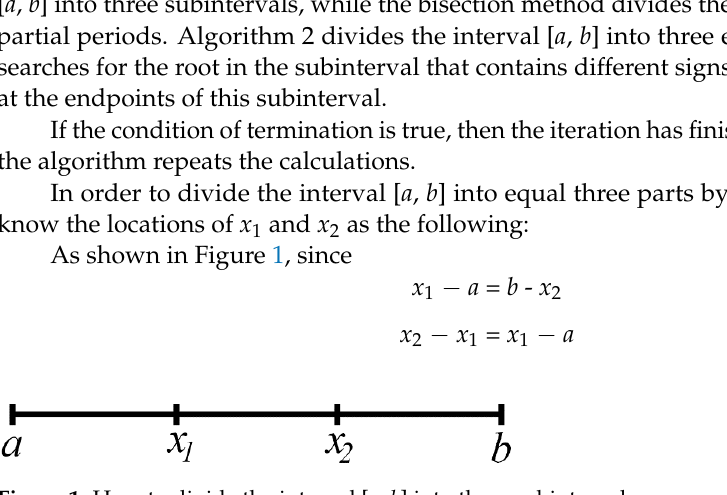
Figure 1. How to divide the interval [ a , b ] into three subintervals.